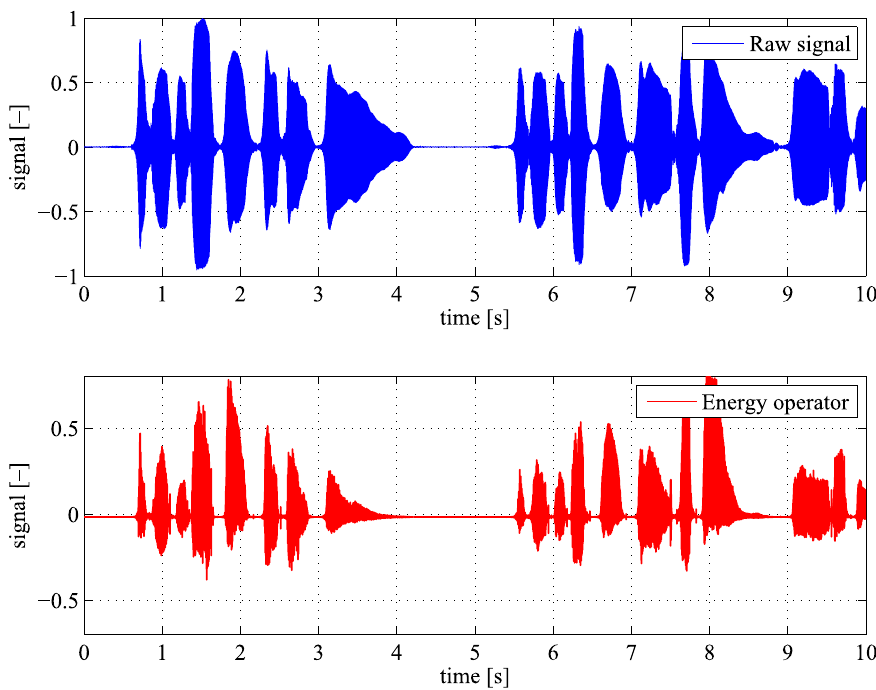
Figure 1. Original signal and the same signal after application of the TKEO